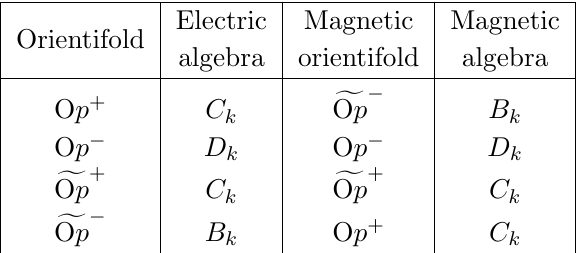
Table 7 . Proposal for magnetic orientifolds [61]. A stack of k physical D5 branes on top of a O5 plane, while being suspended between NS5 branes, has a 5-dimensional low-energy description given by a gauge (cid:12)eld for the electric algebra. In contrast, k identical subwebs suspended between 7-branes on top of a magnetic orientifold O5 contribute to the magnetic quiver as gauge multiplet for the magnetic